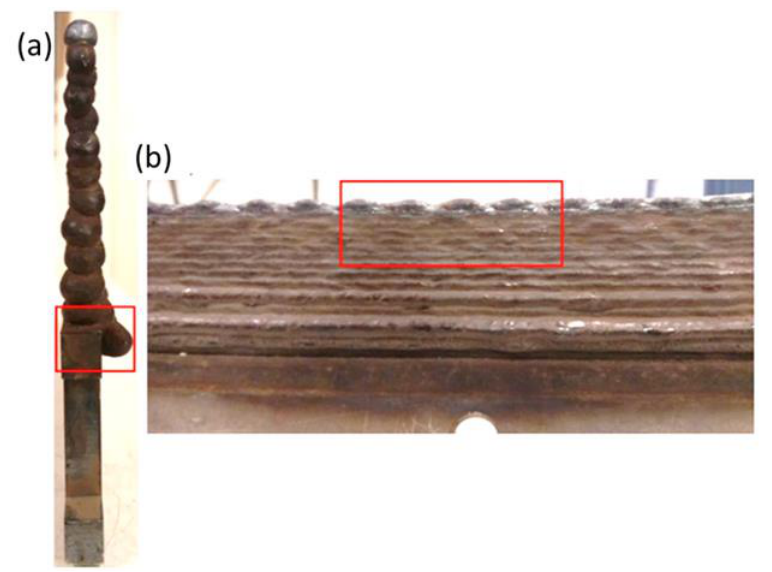
Figure 10. Unacceptable imperfections during WAAM of sequential single layers: ( a ) material flow beyond the side wall; ( b ) top surface undulation.